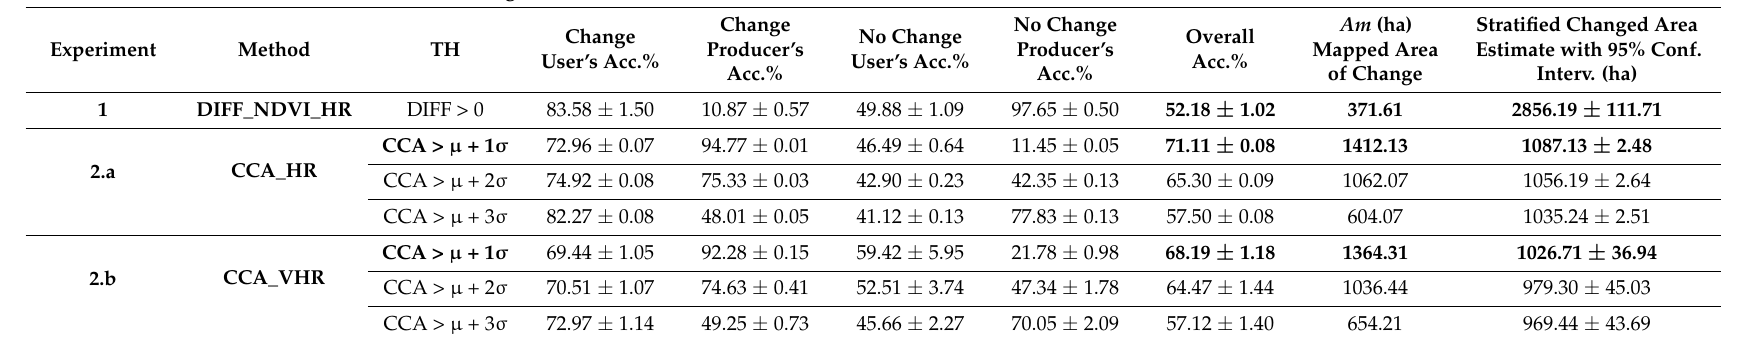
Table 3. Change detection matrix for Murgia Alta site, CCA_HR and CCA_VHR results. Producer’s and overall accuracies based on stratified estimation. TH indicates the threshold value applied to the Z-statistic image in CCA experiments. A m is the mapped changed